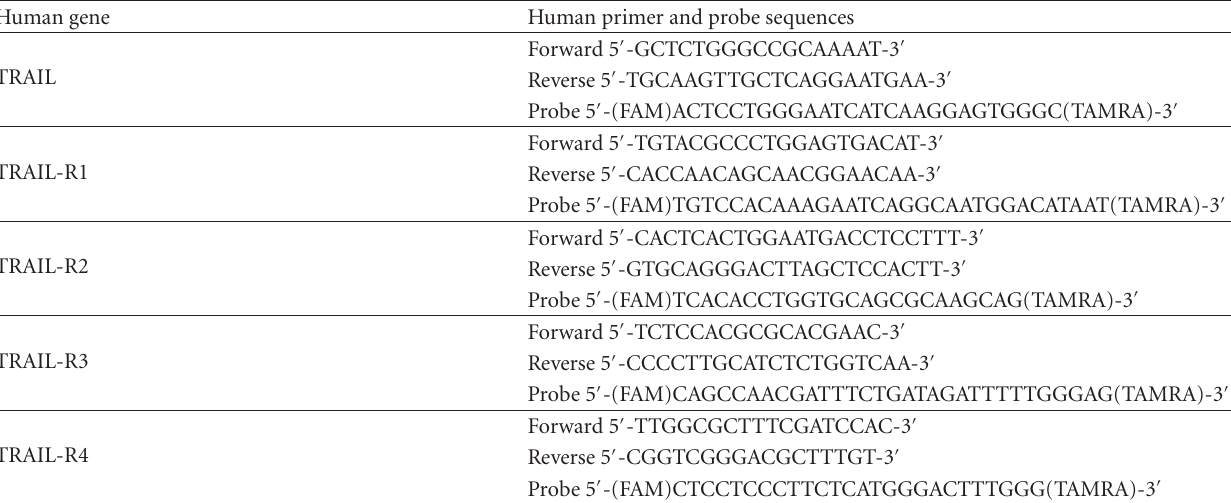
Table 1: Human Taqman Probe and Primer Sequences. Taqman probe and primer sequences for TRAIL and its receptors (R) have been previously